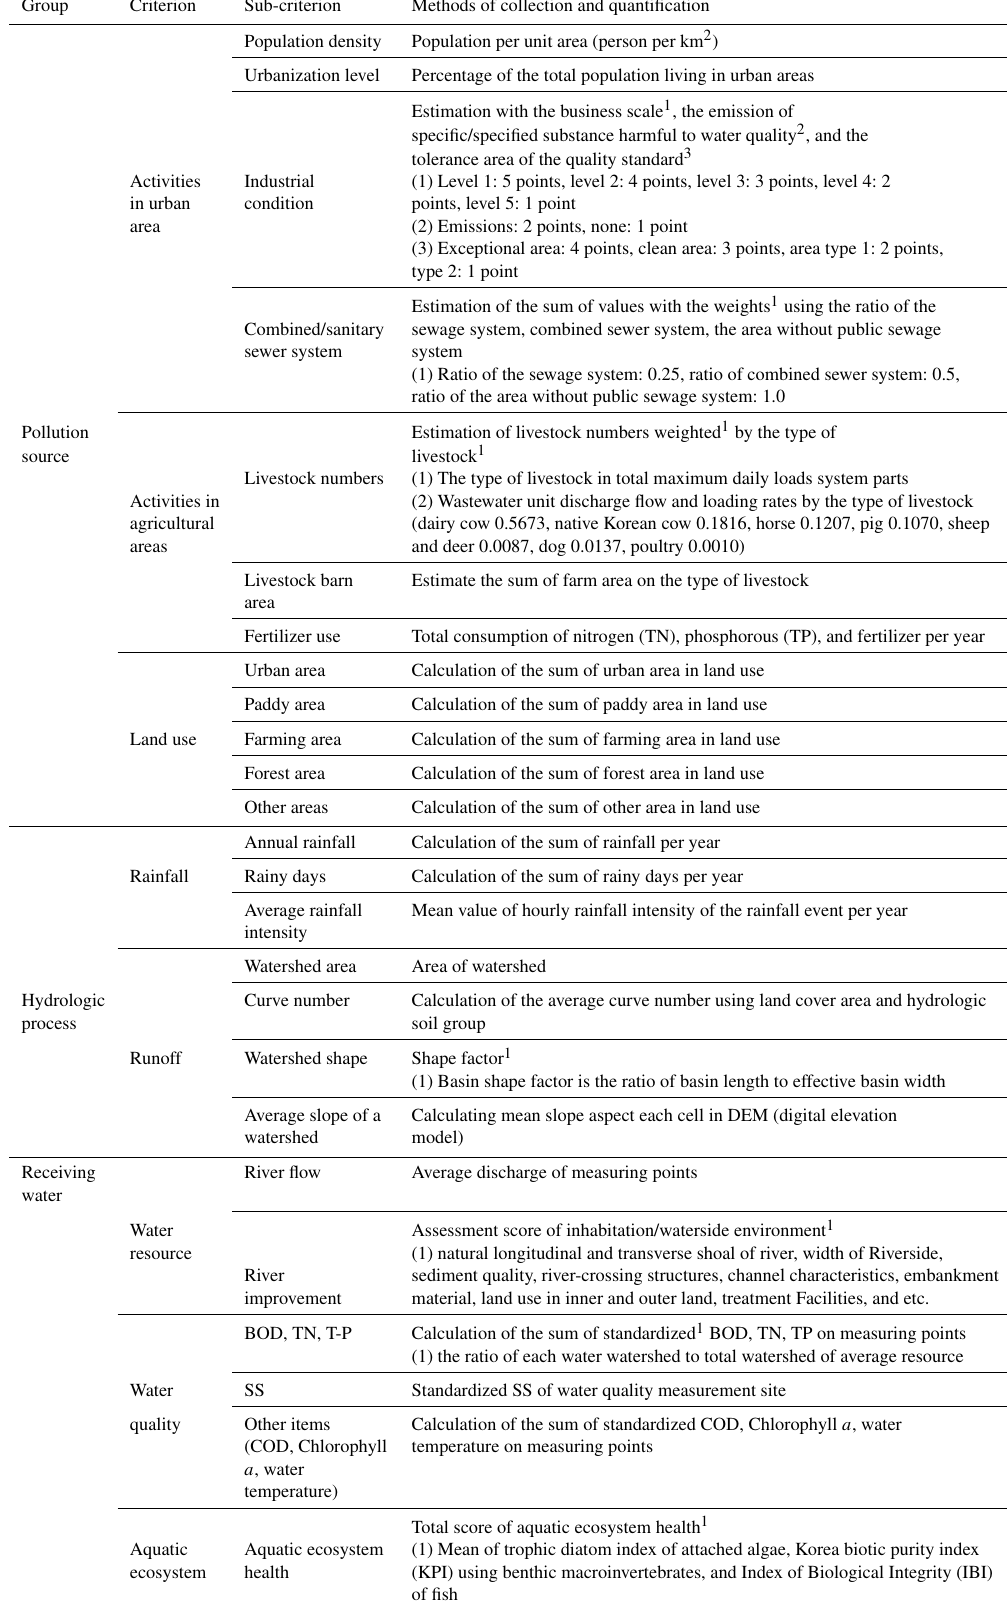
Table 4. Methods of collection and quantification for the criteria.